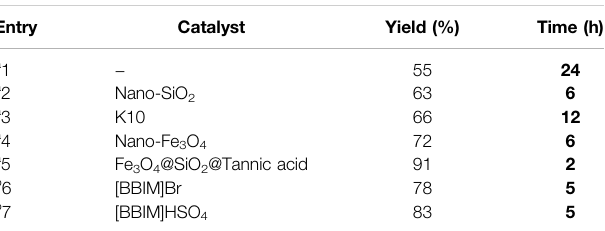
TABLE 1 | In fl uence of catalyst types on reaction time and ef fi ciency in the synthesis of 4a .